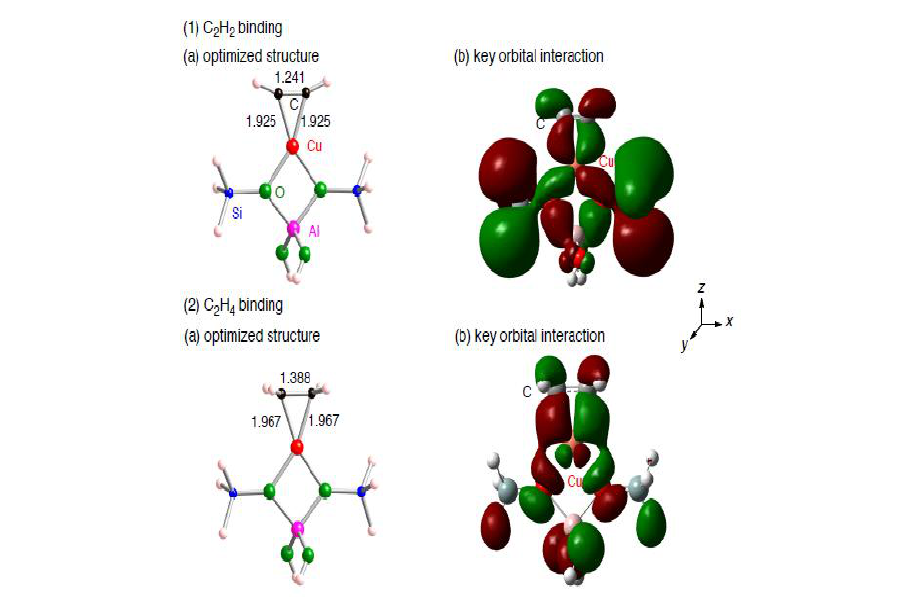
Figure 2. (a) Optimized structures for the binding of an unsaturated hydrocarbon ((1) C or (2) C H ) into the monocopper cation bound to the AlSi 2 4 orbital